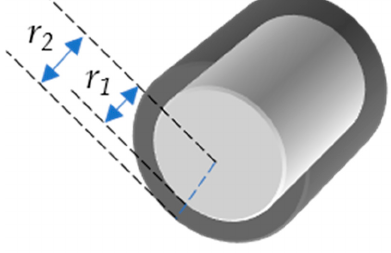
Figure 2. Hollow cylinder with inner radius r 1 and outer radius r 2 .